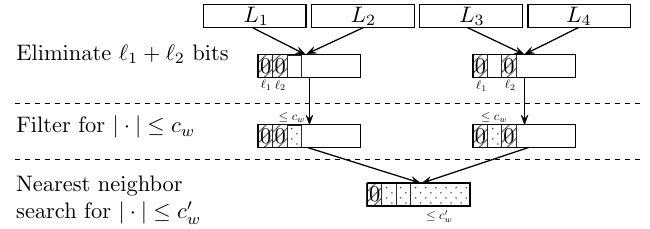
Figure 3: The Approximate k -List Algorithm, k =